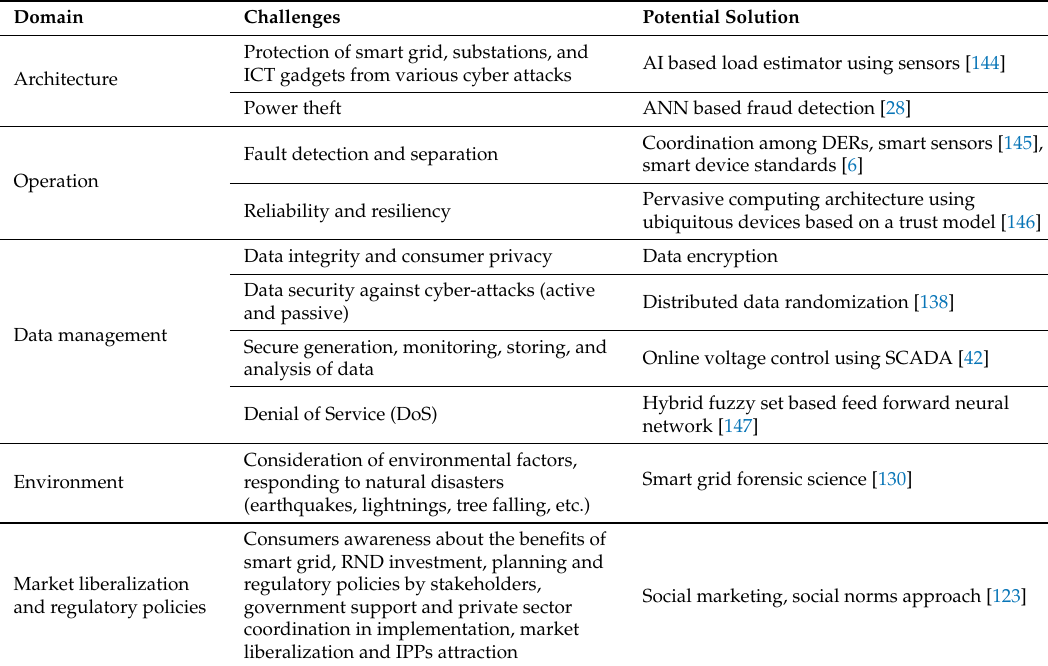
Table 5. AI techniques for various security